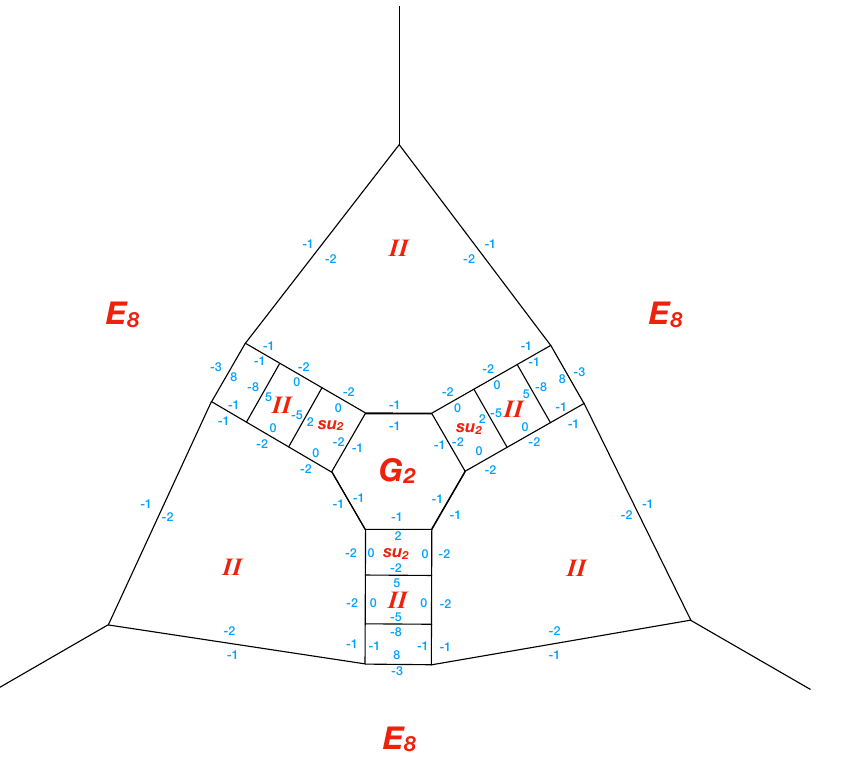
Figure 7 . The partially blown up E 8 { E 8 { E 8 Yukawa